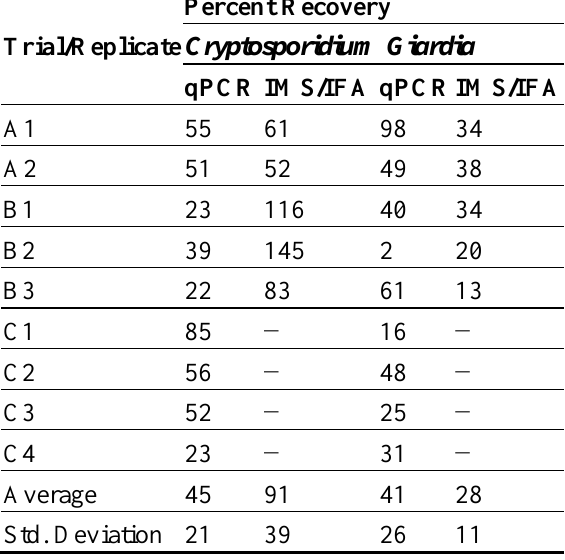
Table 3. Percent Recovery of Cryptosporidium oocysts and Giardia cysts by qPCR vs. IMS/FA. Recoveries incorporate differences in extraction and detection